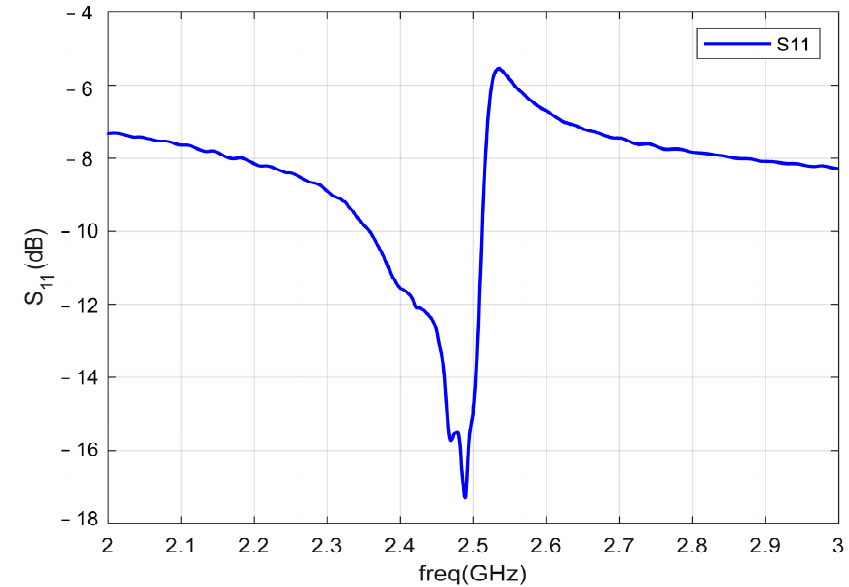
Figure 15. S11 curve of the ME antenna.